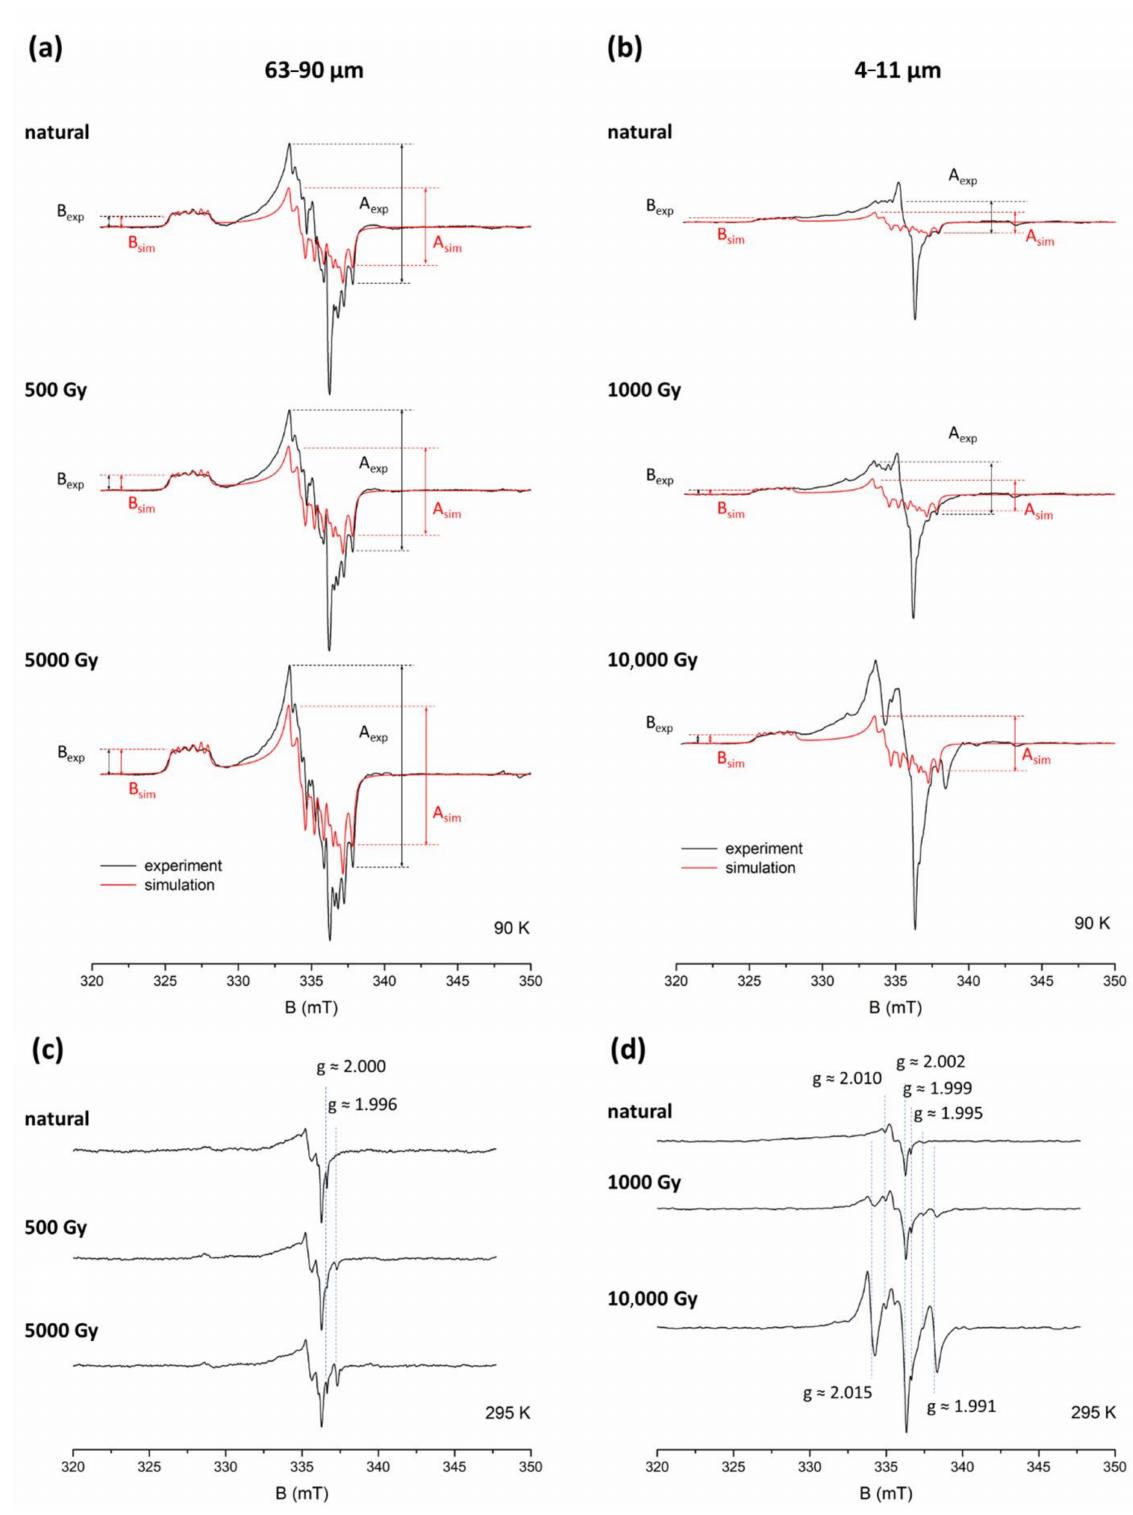
Figure 5. EPR spectra of the coarse (63–90 µ m) and fine (4–11 µ m) fraction of sample 2 MV 80, natural and additionally irradiated with 500 and 5000 Gy for coarse grains, and 1000 and 10,000 Gy for fine grains, recorded at 90 K (( a , b ), respectively) and at room temperature (( c , d ), respectively), and simulated spectra of Al-h signal (in red). Amplitudes A exp , A sim , B exp and B sim are marked with arrows. Major dose-dependent signals observed at room temperature are marked with blue dashed lines. The 90 K spectra for coarse grains are multiplied by a factor of